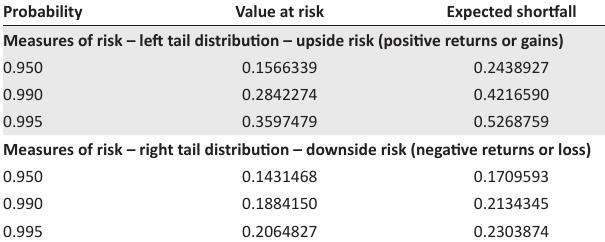
TABLE 3: Risk measures of value at risk and expected shortfall for the right tail and the left tail. Probability Value at risk Expected shortfall Measures of risk – left tail distribution – upside risk (positive returns or gains)